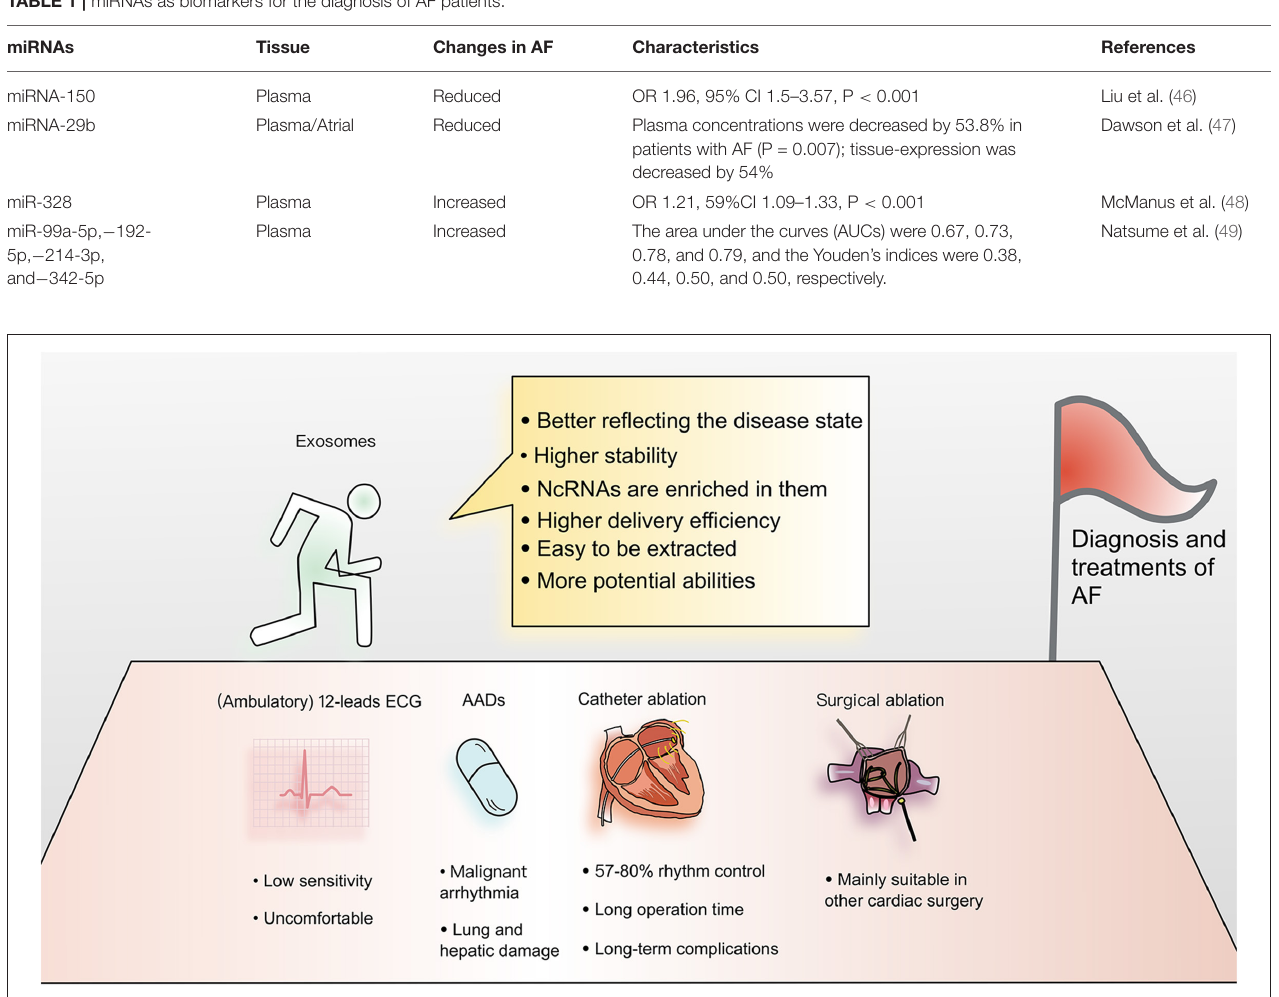
TABLE 1 | miRNAs as biomarkers for the diagnosis of AF patients.